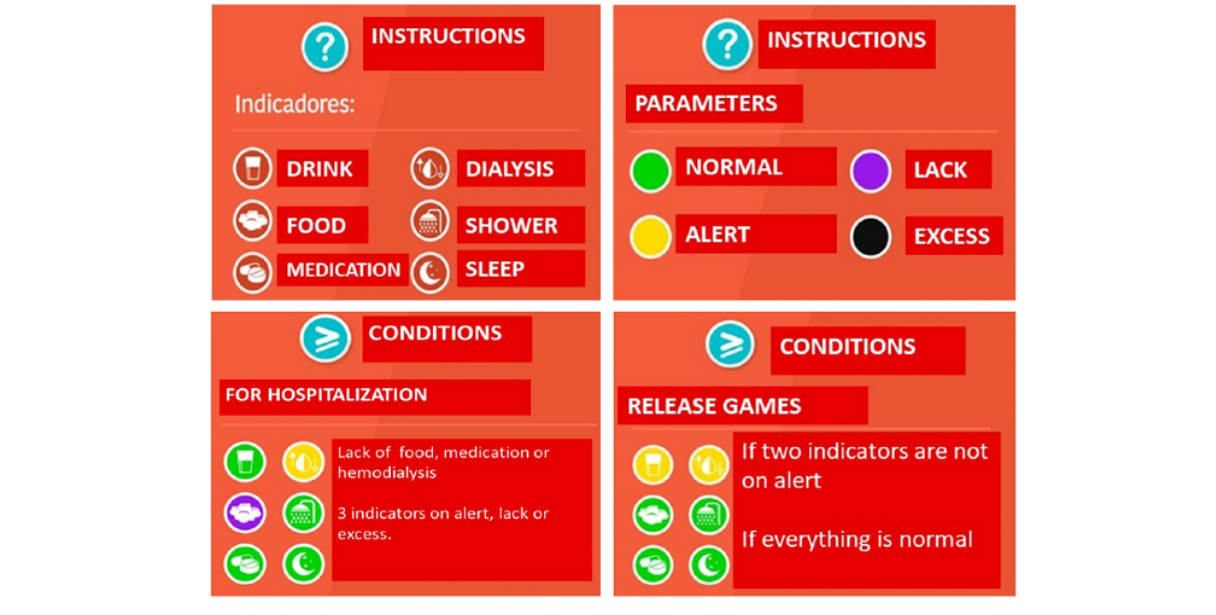
Figure 5. Instructions for the parameters and conditions for hospitalization and the access to bonus games.